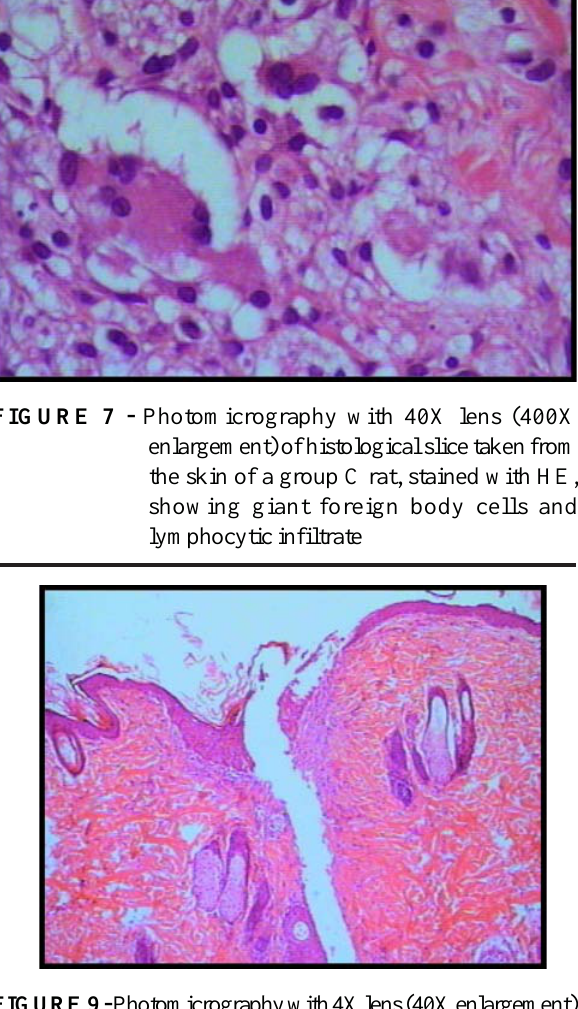
FIGURE 9 - Photomicrography with 4X lens (40X enlargement) of histological slice taken from the skin of a group D rat, stained with HE, showing absence of complete epithelialization after 7